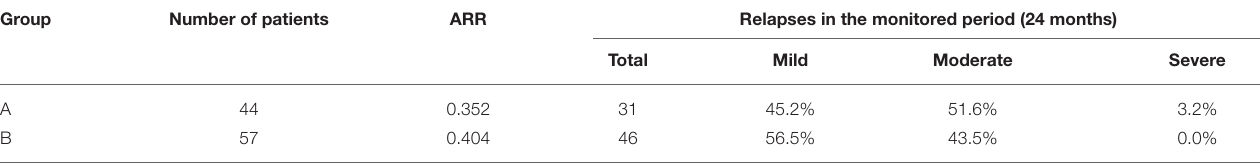
TABLE 2 | Average annual relapse rate (AAR) and the characteristics of relapses during the follow-up period. Group Number of patients ARR Relapses in the monitored period (24